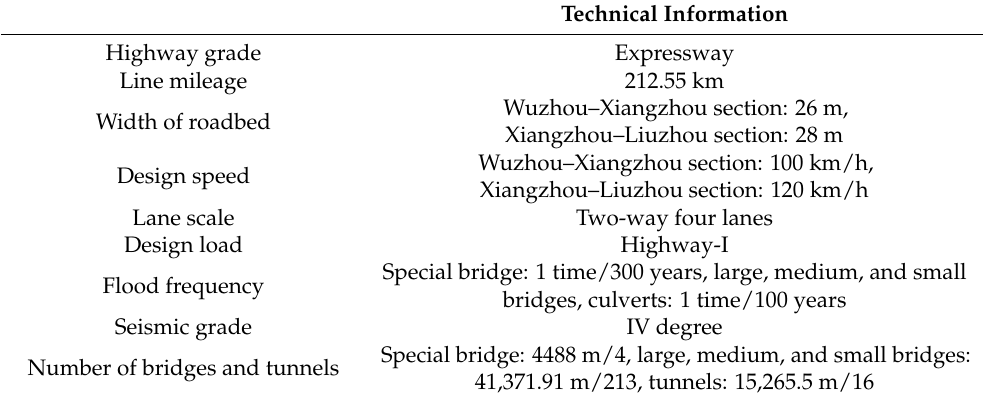
Table 2. Technical Standards of Wuzhou–Liuzhou Highway.